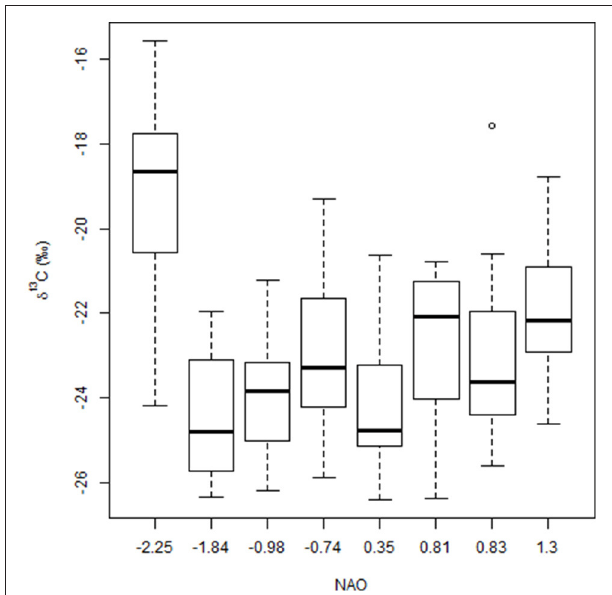
FIGURE 5 | Boxplots of δ 13 C binned by North Atlantic Oscillation (NAO) index values (from ftp://ftp.cpc.ncep.noaa.gov/wd52dg/data/indices/ nao_index.tim) where associated cruise numbers were (from left to right): HB1202, DE1012, DE1105, PC1207, DE1102, GU1305, GU1302, and DE1109. See Table 1 for details of corresponding sampling months and